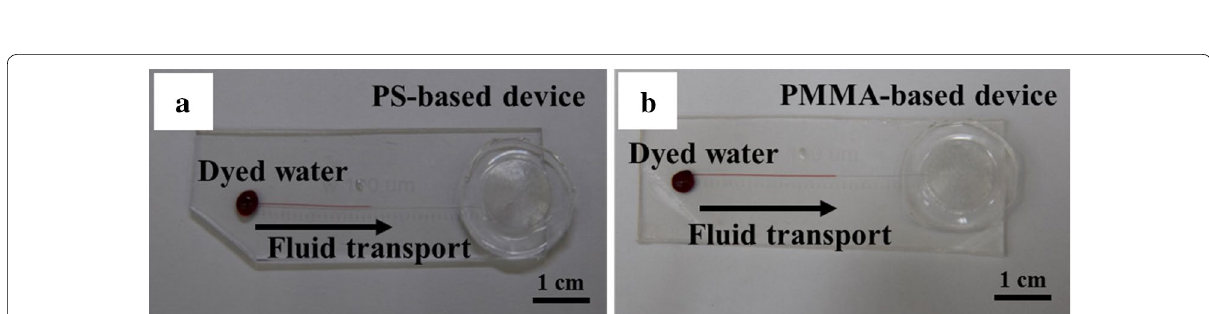
Fig. 5 Application of the PDMS suction cup for the equipment-free pumping of the thermoplastic-based microfluidic devices. A finger-triggered